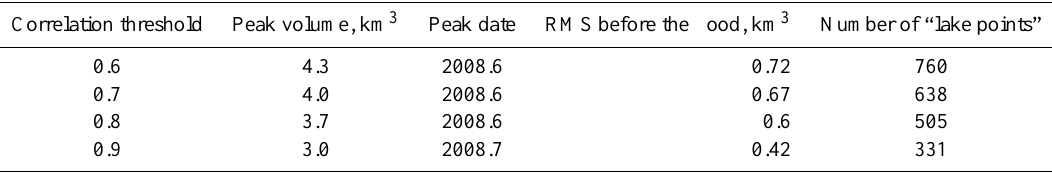
Table 2. Properties of the estimated volume of water downstream of Lake Cook E2 for different values of “correlation threshold” . Value reported here includes a correction for the elevation changes measured for non-lake points (Fig. 8b). The correlation indicates the quality of a Gaussian fit to the Envisat elevation times series (see Sect.